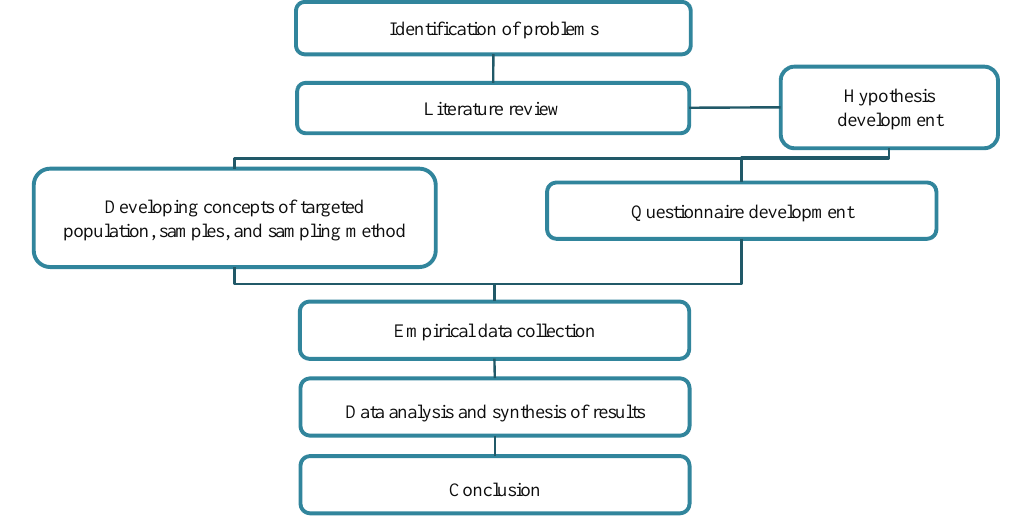
Figure 2. Flow chart of the research